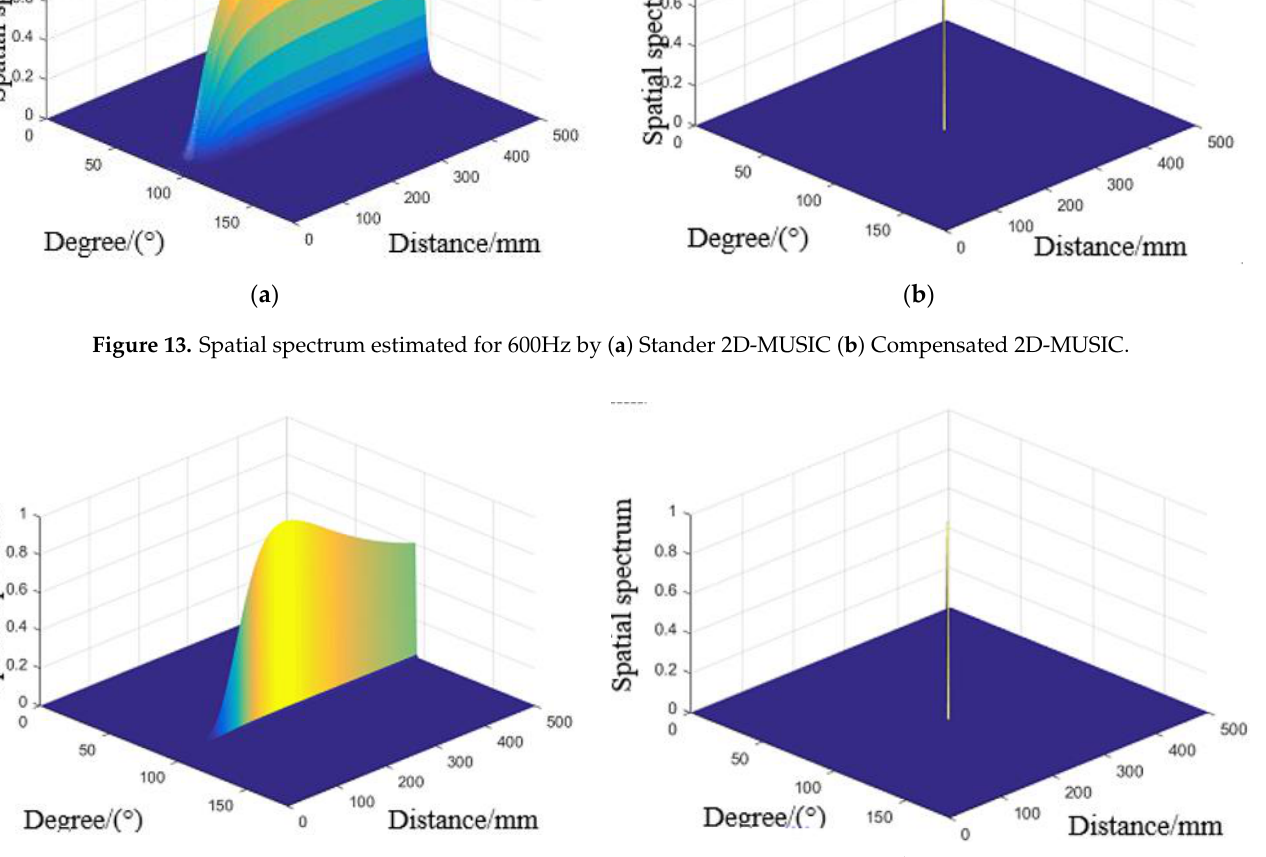
Figure 14. Spatial spectrum estimated for 2.41 rad/m by ( a ) Stander 2D-MUSIC ( b ) Compensated 2D-MUSIC.